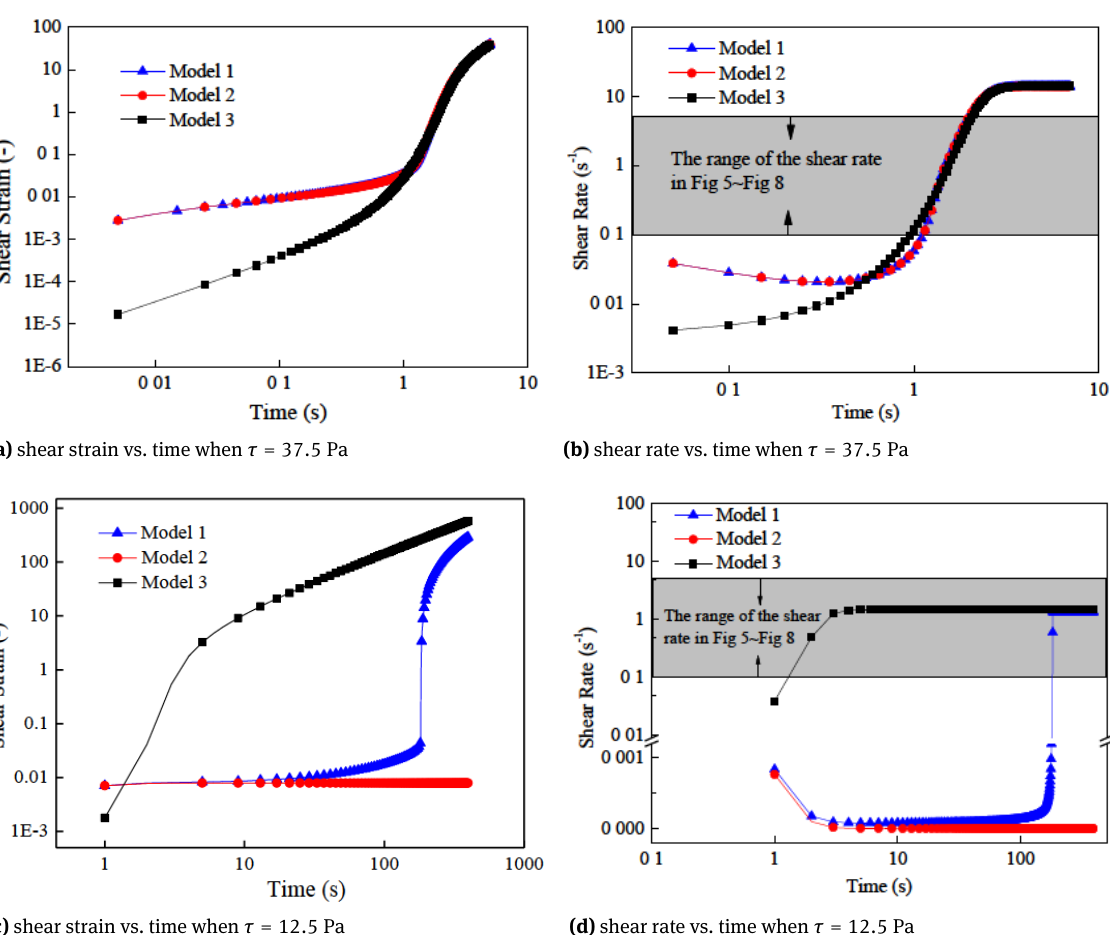
els, as shown in the Figure 17(b), is close to the range of the shear rate in the rheology tests shown in Figures 5-8. Both calculated shear strain and shear rate using Model 3 are different from what were obtained from Model 1 and Model 2 at the initial